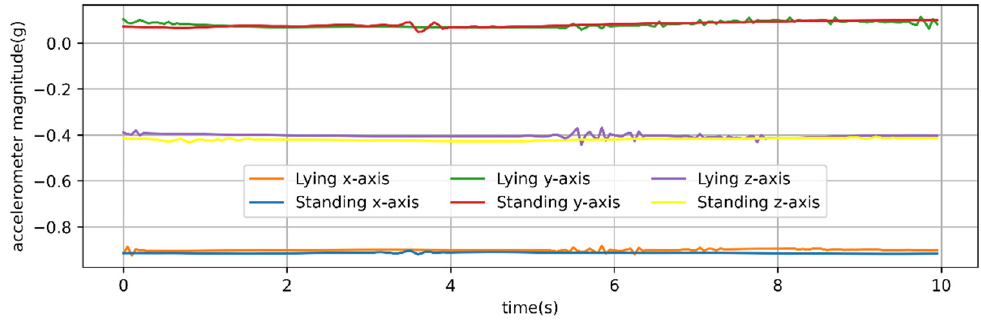
Figure 14. Time series of three-axis accelerometer signals from a 20 Hz sampling rate for 10 s of observed behaviors of B-Sheep standing and P-Sheep lying. Acceleration was in g (9.8 m/s 2 ) units.